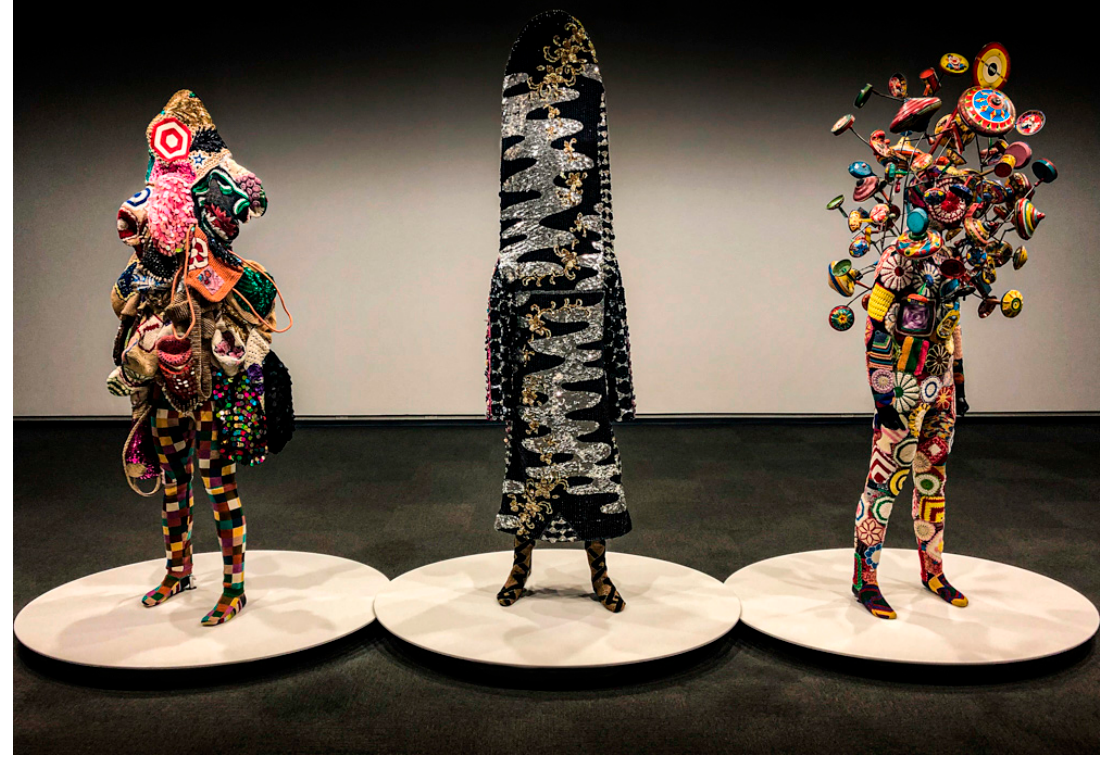
Figure 5. Nick Cave Soundsuits (Photo by Chris Friese https://www.flickr.com/photos/free-zee/48227357961/).